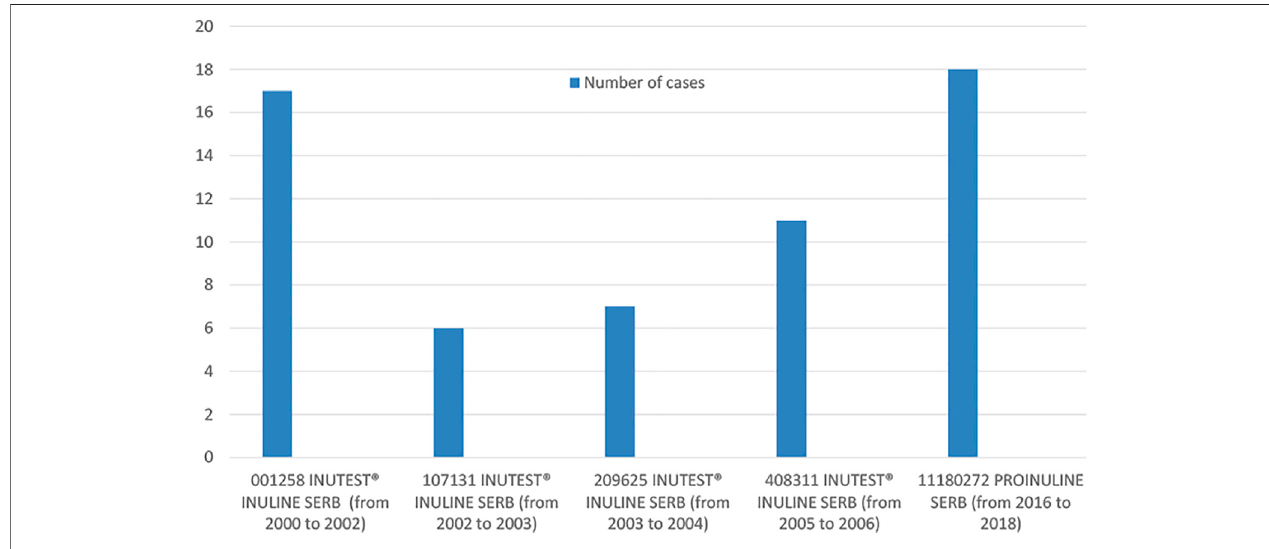
FIGURE 1 | Distribution of cases in batches associated to the occurrence of 5 cases or more of ARs, based on batch number and year of occurrence.